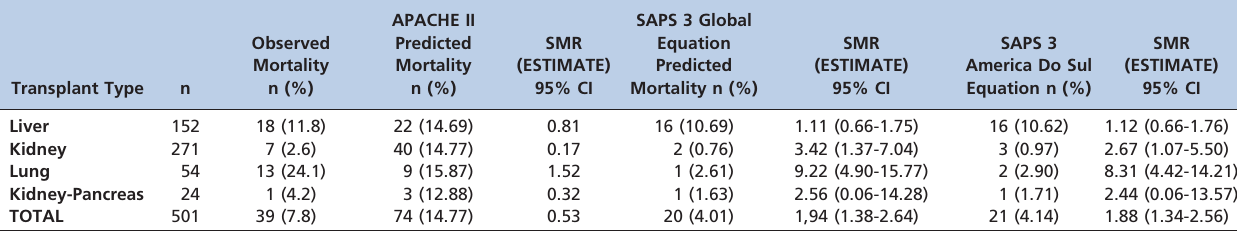
Table 2 - Relationship between observed and predicted mortality rates within each group according to the SAPS 3 global equation, South America customized equation and APACHE II.